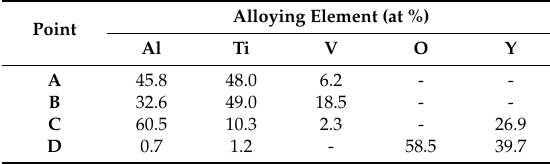
Figure 3. BSE images of the as-forged Ti-43Al-9V-0.2Y alloy: ( a ) low magnification; ( b ) high magnification. Table 1. EDS analyses of grains, lamellae, and particles in the as-forged Ti-43Al-9V-0.2Y alloy. Alloying Element (at %) Point